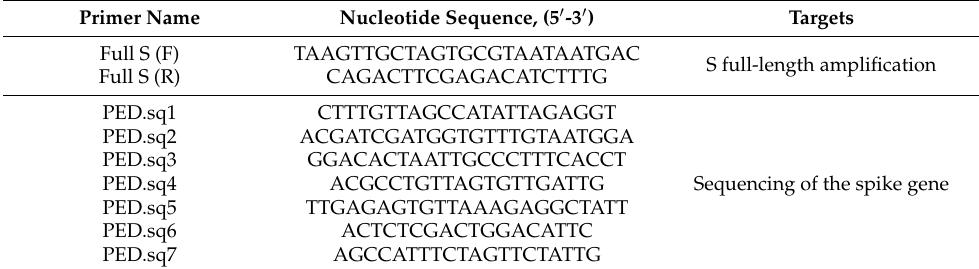
Table 2. List of primers used in the study.